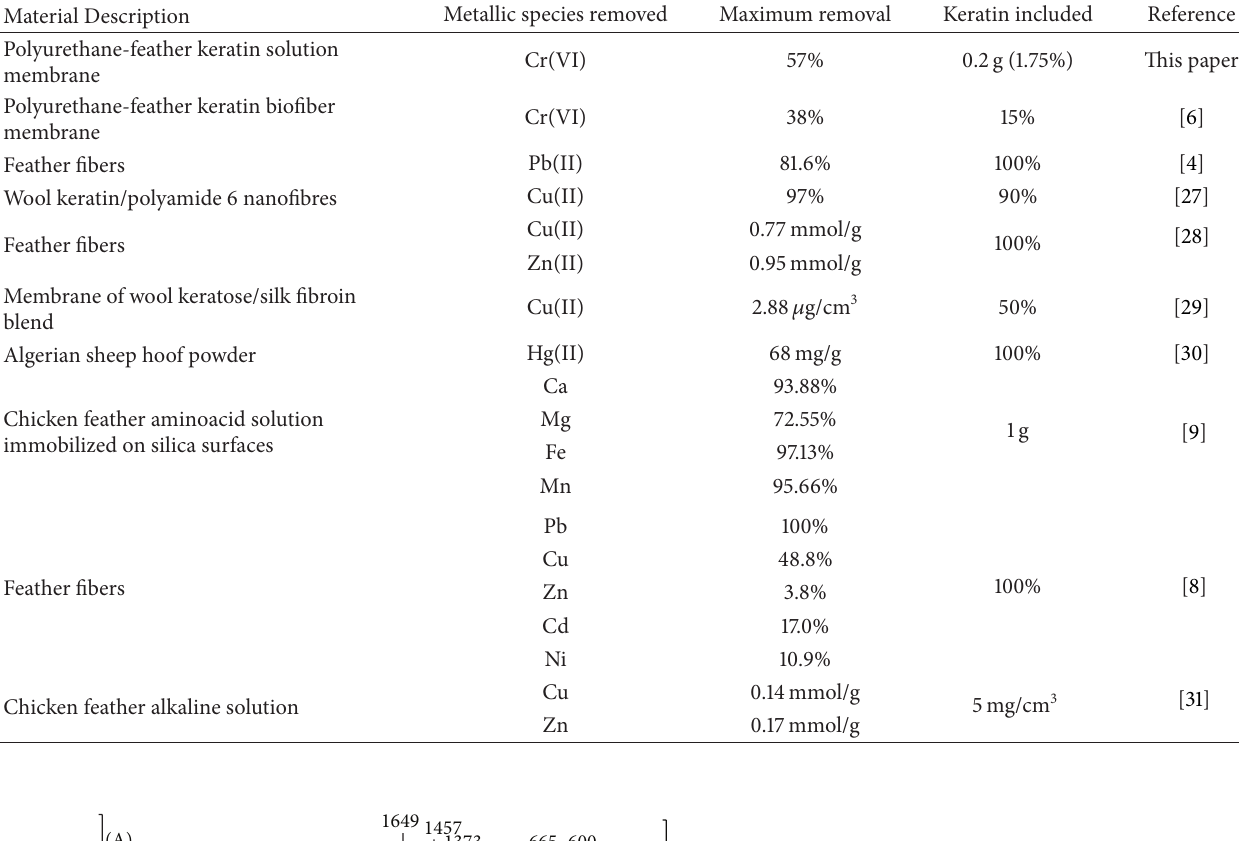
Table 3: Keratin as biosorbent or functional component in materials applied in removal of metal pollution from water.